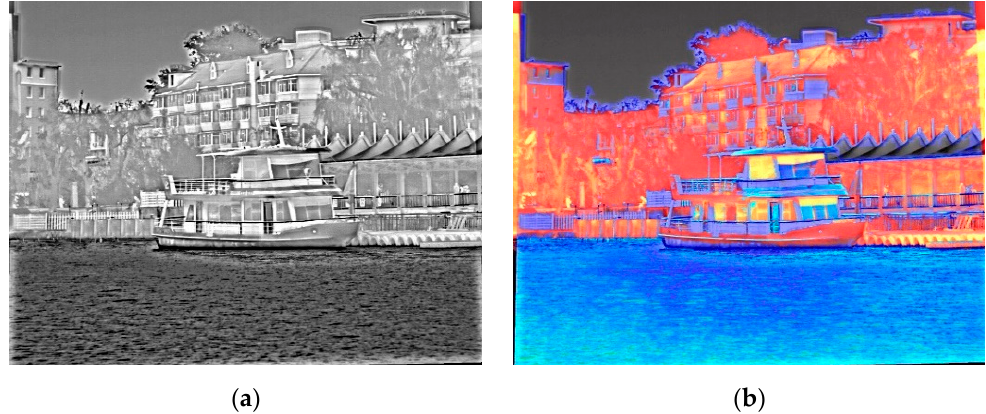
Figure 13. ( a ) Fusion grayscale image. ( b ) pseudo-color enhancement image (red indicates infrared highlighting, blue indicates polarization highlighting).